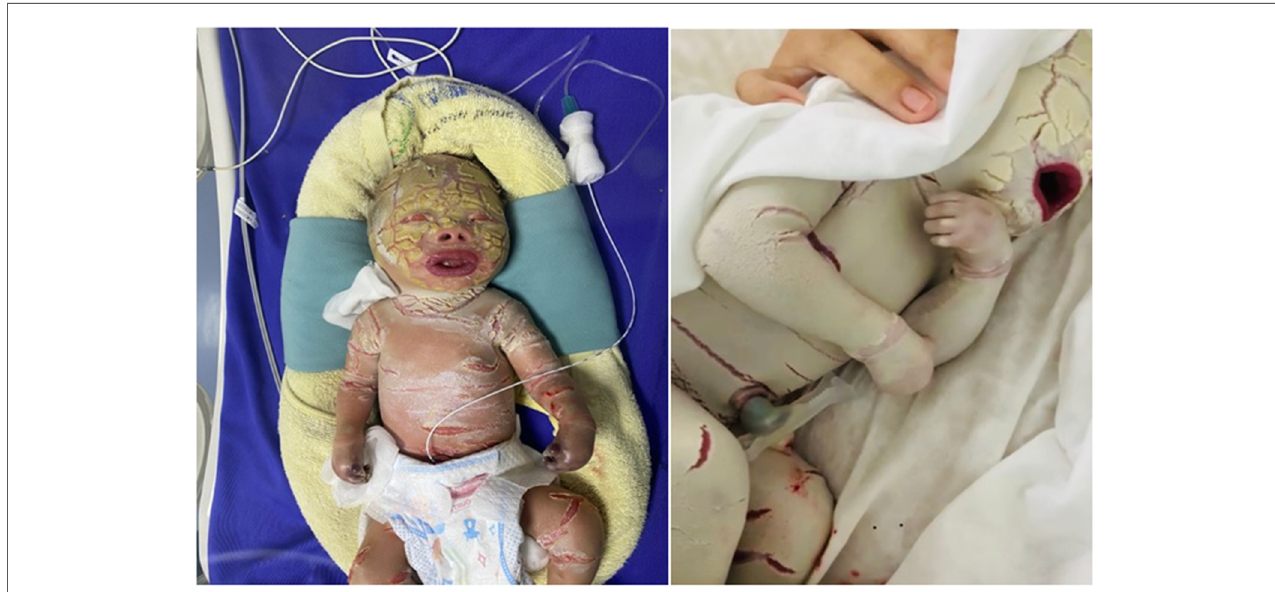
FIGURE 1 Image of patient with characteristic clinical manifestations of the HI disease. The patient ’ s body is covered with a thick layer of skin and deep fi ssures. Patient also has abnormal eyes and ears; fl atter lipids and nose; necrotizing fi ngers and toes after